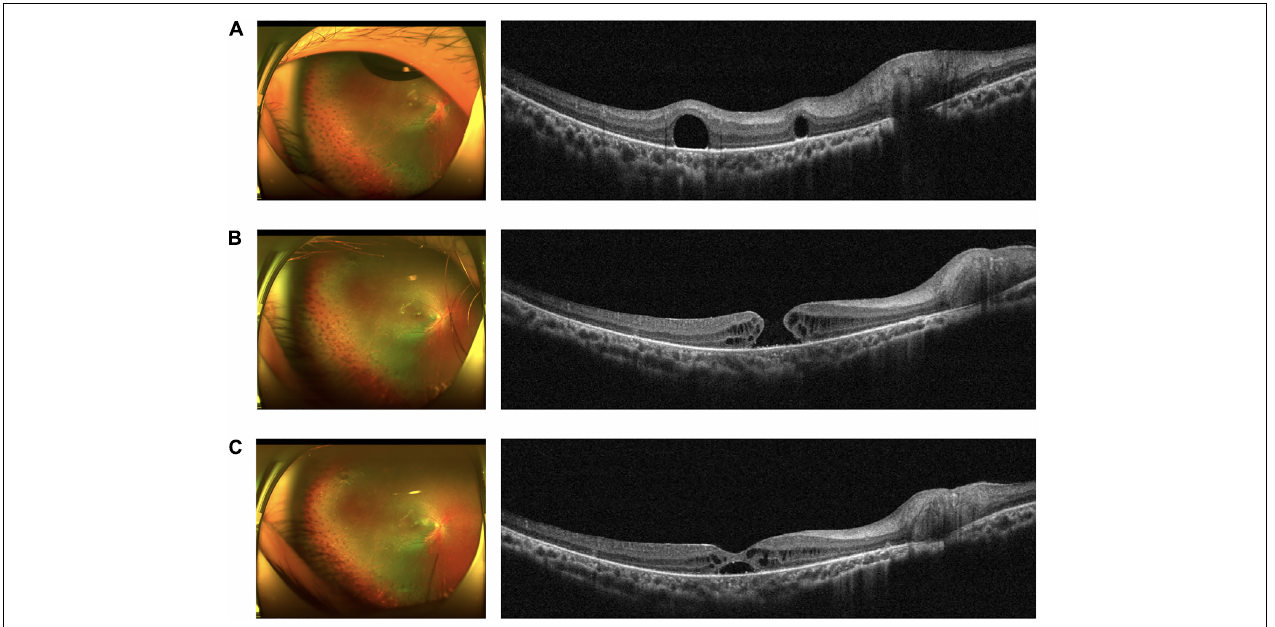
FIGURE 3 | Series of fundus images in case 7, with a self-healing MH as a post-operative complication. (A) Pre-operative fundus photograph (left) and OCT image (right) showing a subfoveal PFCL droplet. (B) Fundus photograph (left) and OCT image (right) showing a full-thickness MH. (C) Fundus photograph (left) and OCT image (right) showing a self-healing MH with macular intraretinal edema and subretinal